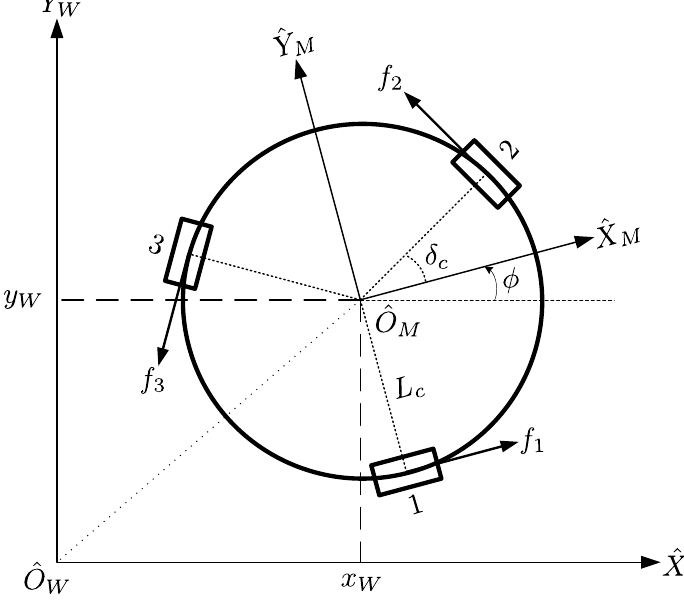
Figure 2. The omni-directional wheeled mobile robot from the top